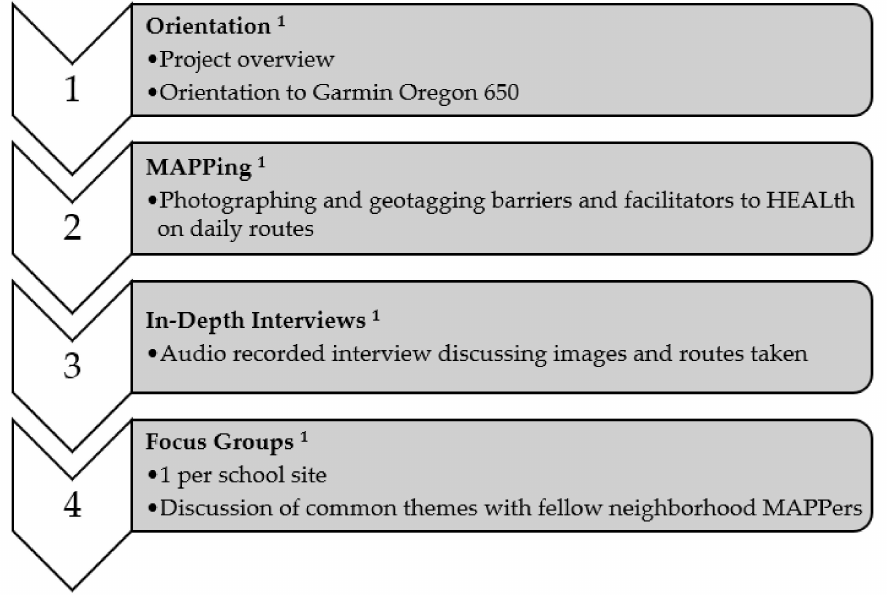
Figure 1. Phases of the Project SWEAT HEALth MAPPS TM Sub-Study: 1 Orientation: Families were introduced to the HEALth MAPPS TM and Garmin Oregon 650 via an orientation handout to explain the objectives of the project, the participants’ role within the project, and functions of the tracking device. Participants were compensated with USD 20 in cash to purchase food while on their routes. MAPPing: Caregivers and their children used the Garmin Oregon 650 together to map as many commonly traveled routes as desired. Participants took images of their facilitators and barriers to healthy eating and active living. Participants were also asked to photograph any food purchases they made while on their routes. In-Depth Interviews (IDIs): Caregivers participated in audio recorded in-depth interviews with questions based on the HEALth MAPPS TM protocol [18]. Participants were verbally asked to identify facilitators and barriers to healthy eating and active living within their images taken on their route with the HEALth MAPPS TM Route Journal [18]. Focus Groups: Focus Groups were conducted at each respective school site, with a separate focus group for caregivers and children. Caregivers were asked to discuss a series of questions or statements regarding their neighborhoods with researchers ( n = 2) acting as a moderator and a field note